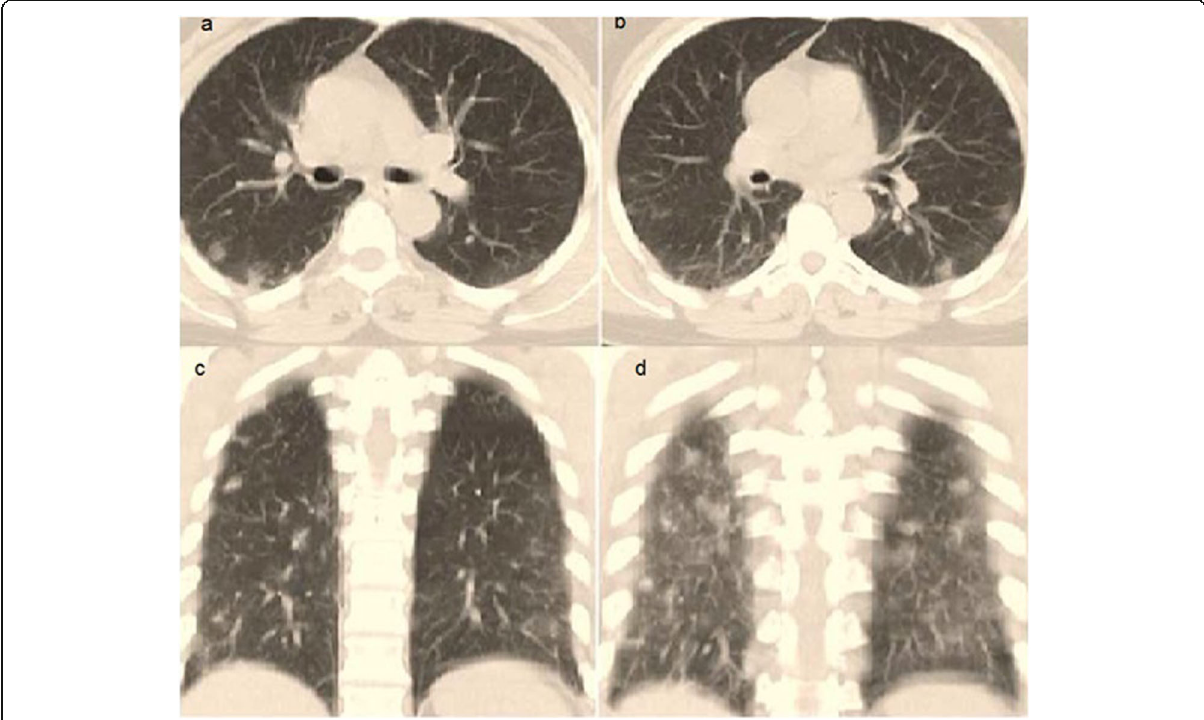
Fig. 4 “ A 56-year-old female patient with a history of thyroid cancer. ” MCCT exam revealed multiple well-defined solid nodules scattered throughout both lung parenchyma ( a , b ) axial and ( c , d ) coronal images that are categorized as lung-RADS score 4X, “ malignant metastatic solid nodular lesions ” that showed an increase in size and number in follow-up examinations which proved to be metastatic malignant nodules